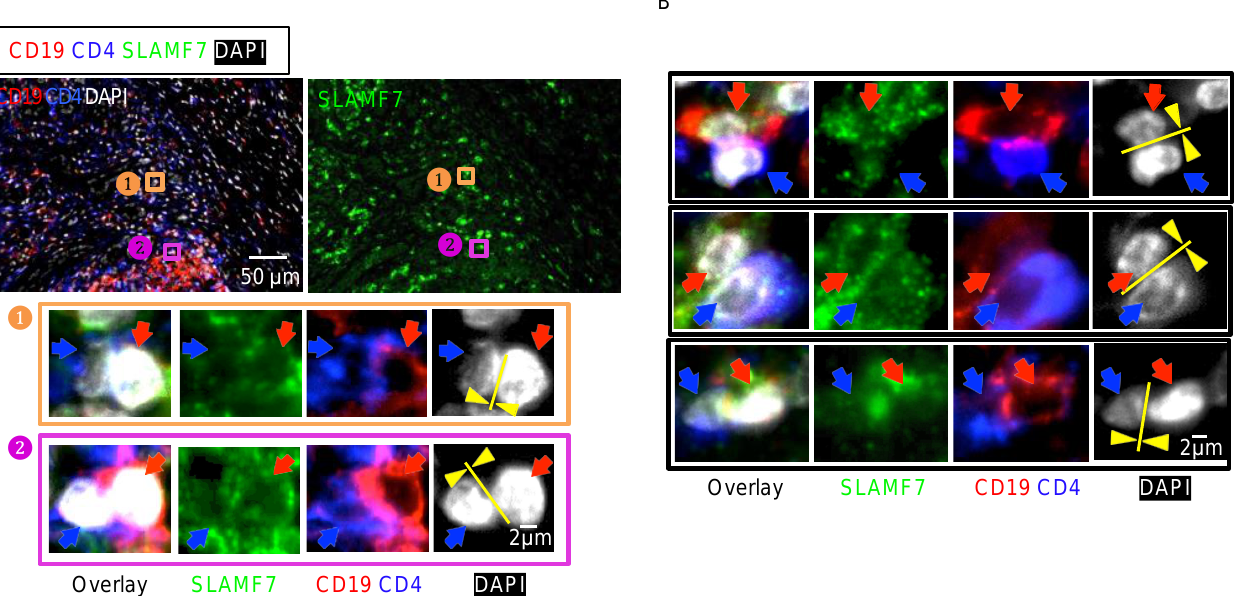
Figure 2. High numbers of CD4 + CTLs and activated B cells are frequently conjugated in IgG4-RD. ( A ) Representative multi-color immunofluorescence images of CD19 (red), CD4 (blue), SLAMF7 (green), and DAPI (white) staining in a submandibular gland from a patient with IgG4-RD. Orange and pink rectangles represent SLAMF7 + CD4 + CTLs (blue arrows), SLAMF7 + activated B (red arrows) cells, and cells that they are in contact with. ( B ) SLAMF7 + CD4 + CTLs (blue arrows), SLAMF7 + activated B (red arrows) cells, and cells they are in contact with, in IgG4-RD tissue lesions.